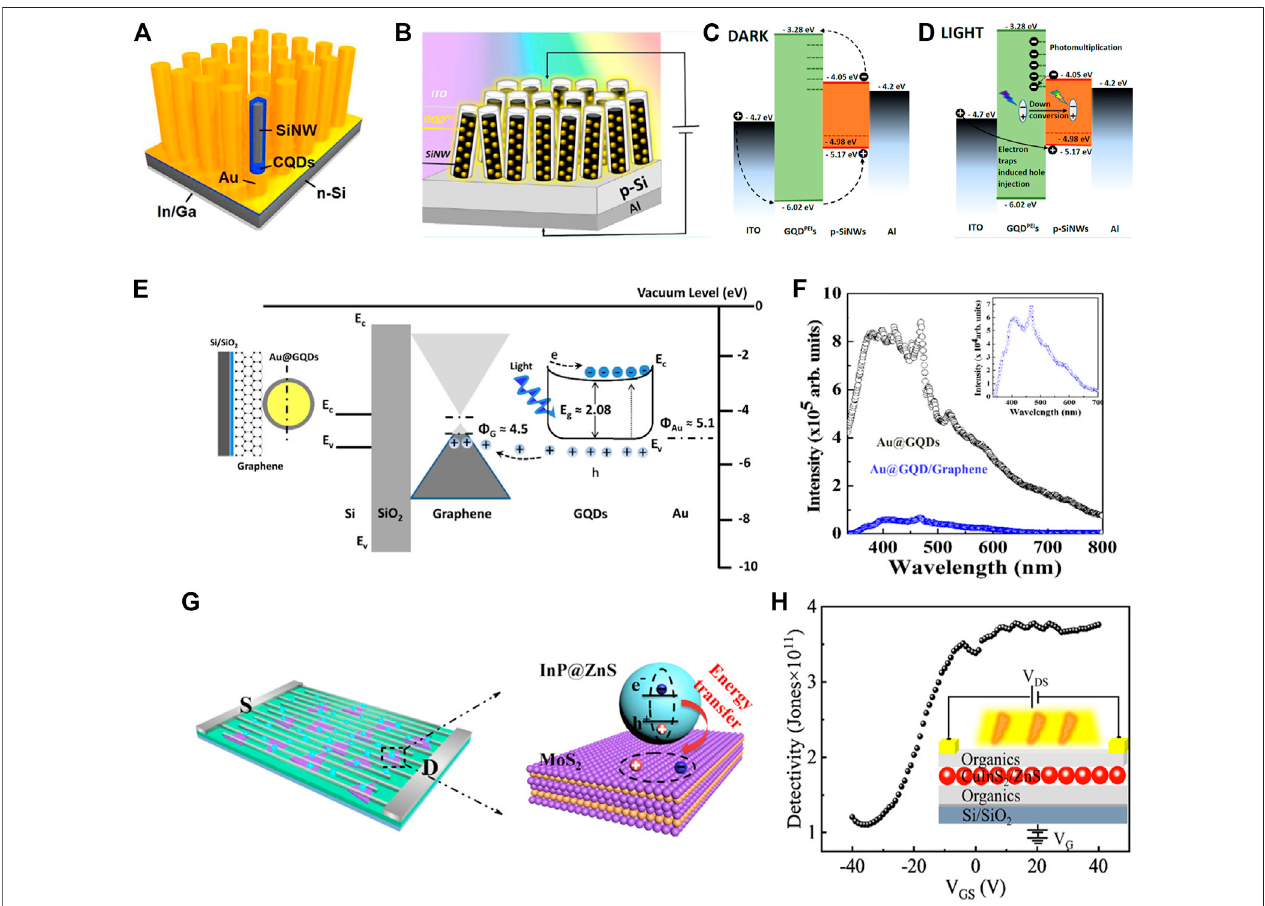
FIGURE5|(A) ThestructureoftheSiNWarray/carbonQDheterojunctiondevice. (B) TheschematicoftheGQD PEI /SiNWcore – shellstructuredevice.Energyband diagram of the ITO/GQD PEI /SiNW/Al device under reverse bias (C) in dark and (D) under illumination. (E) Illustration and energy level diagram of the PD using Au@GQD nanohybrids. (F) PL spectra of Au@GQD (black line) and Au@GQD/graphene (blue line) under incident light of 325 nm with a magni fi ed PL spectrum of Au@GQD/ grapheneintheinset. (G) StructuraldiagramandschematicoftheInP@ZnS-MoS 2 hybridenergytransfersystem. (H) SchematicviewoftheQDphotodetectorand representative detectivity performance. (A) Reprinted with permission from ACS Nano 2014, 8, 4015 – 4022. Copyright 2014 American Chemical Society. (B –